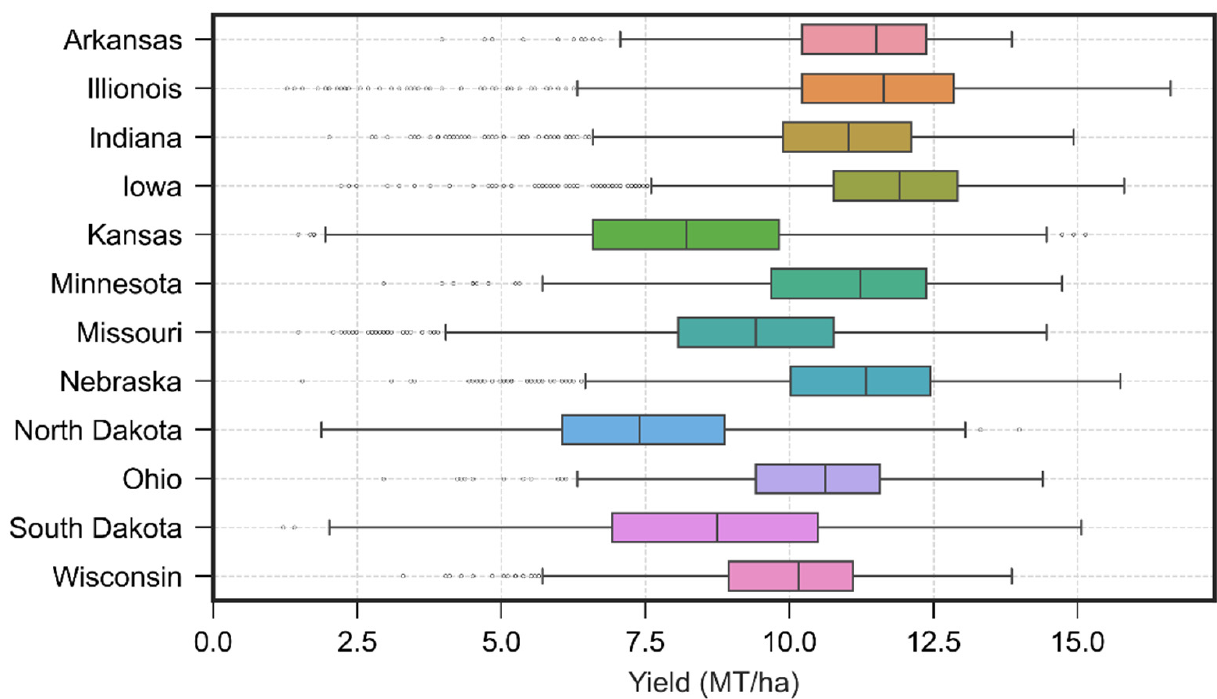
Figure 3. State-wise corn yield distributions in the US Corn Belt (2006–2020).